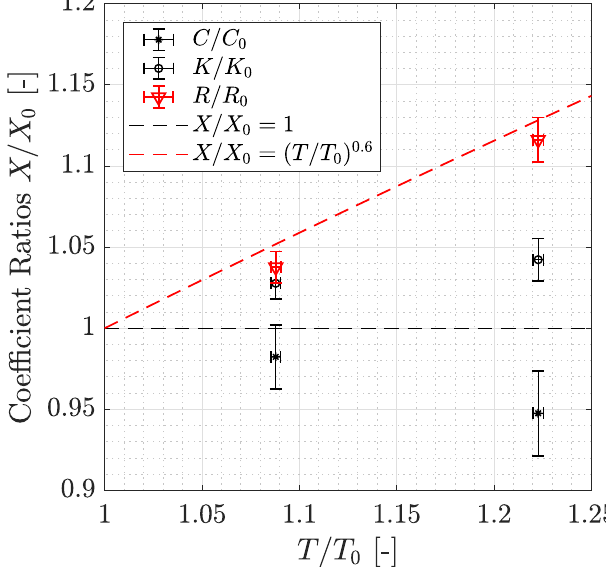
Figure 6. Change of material constants C / C 0 , K / K 0 and R / R 0 with temperature for t = 6cm. Black dashed line indicates the constant coefficient ratio as expected for the geometrical constants C and K . The theoretical relation for R according to Equation (2) with n = 0.6 is indicated in red. Error bars represent regions which contain 68 % of simulated